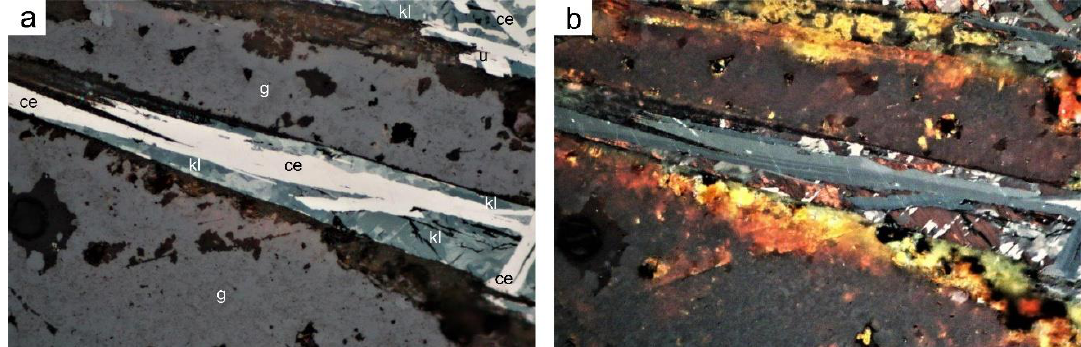
Figure 5. Type-II cerromojonite-bearing pseudomorph progressively altered by goethite and sulfides (reflected light, horizontal field of view is 500 µm). Abbreviations: ce = cerromojonite, ch = chalcopyrite, cl = clausthalite, co = covellite, g = goethite, kl = klockmannite, k–p = krut’aite  penroseite solid solution, p = penroseite, w = watkinsonite, u = unnamed CuNi 2 Se 4 .